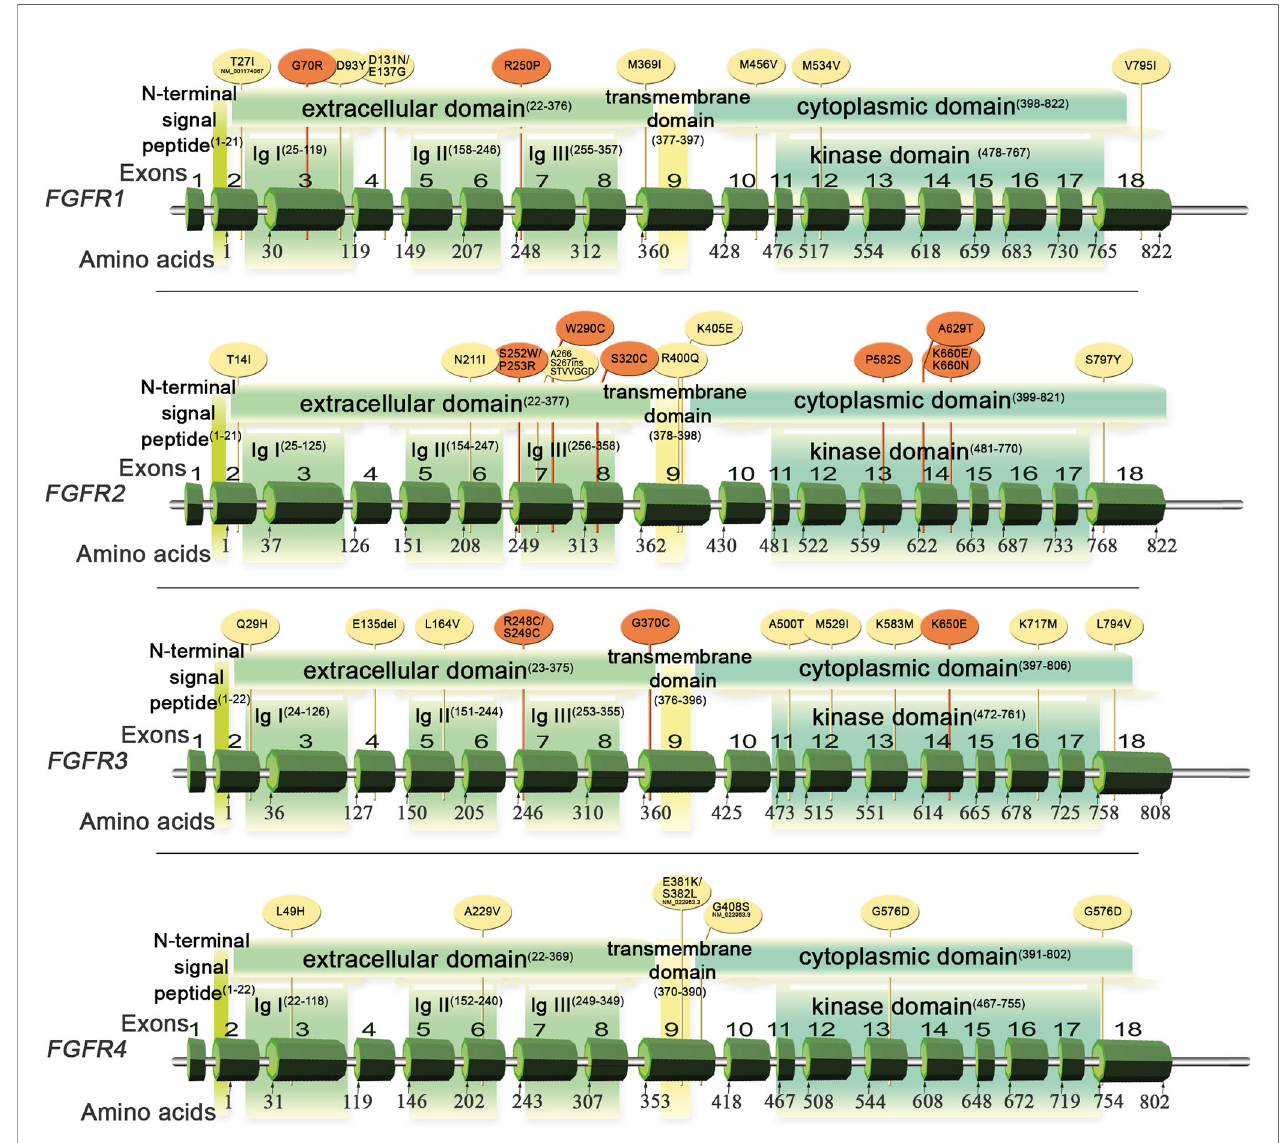
FIGURE 1 | Schematic of FGFR1 – 4 genes and protein structures with variants detected in Sq-NSCLC tissue ( Table 1 ). Red, pathogenic or likely pathogenic clinical signi fi cance; yellow, variants not in the ClinVar